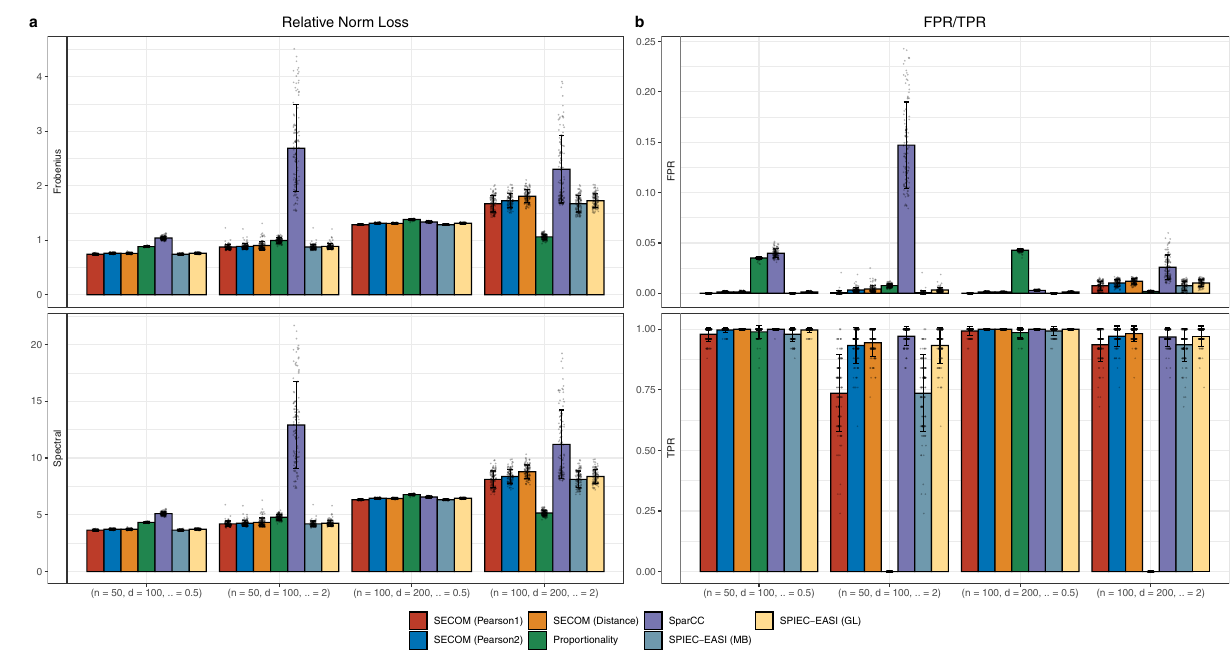
Spectral norm loss, or FPR/TPR)±standard errors (shown as error bars) across 100 simulation runs foreach n / d / α setting. Datapoints are added to the bar charts using dots with jittering. Color and the name of the corresponding correlation methods are shown at the bottom of the graph. The results demonstrate that SECOM and SPIEC-EASI outperformed all existing methods not only in terms of estimation accuracybut also interms of uniformlysmallFPR and